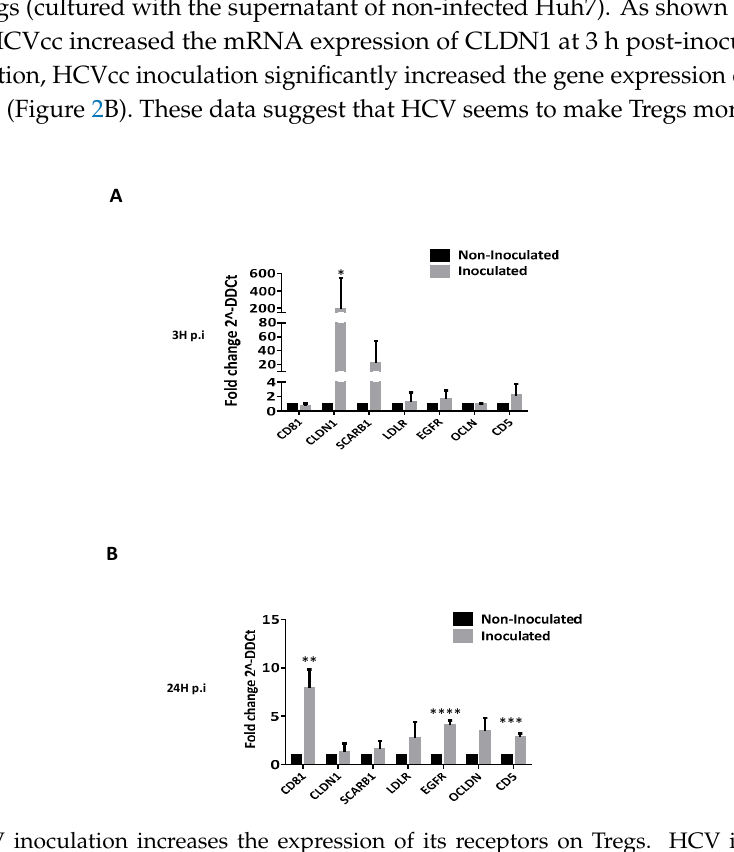
Figure 2. HCV inoculation increases the expression of its receptors on Tregs. HCV inoculation increases the mRNA expression of CLDN1 and SCARB1 at 3 h post-inoculation (3 h p.i) ( A ) and CD81, EGFR and CD5 at 24 h p.i ( B ). Gene expression is normalized using GADPH, beta-actin, 18s and Hypoxanthine-guanine phosphoribosyltransferase (HRPT) mRNA as a housekeeping-gene before GADPH, beta-actin, Hypoxanthine-guanine being reported to non-inoculated Tregs (black bars ). Results represent means of five independent phosphoribosyltransferase (HRPT) mRNA as a housekeeping-gene before being reported experiments and are presented as fold change (2 – ∆∆ Ct ) ± SEM bars. p ≤ 0.05 (*), p ≤ 0.001 (**), p ≤ 0.0001 (***) and p ≤ 0.00001